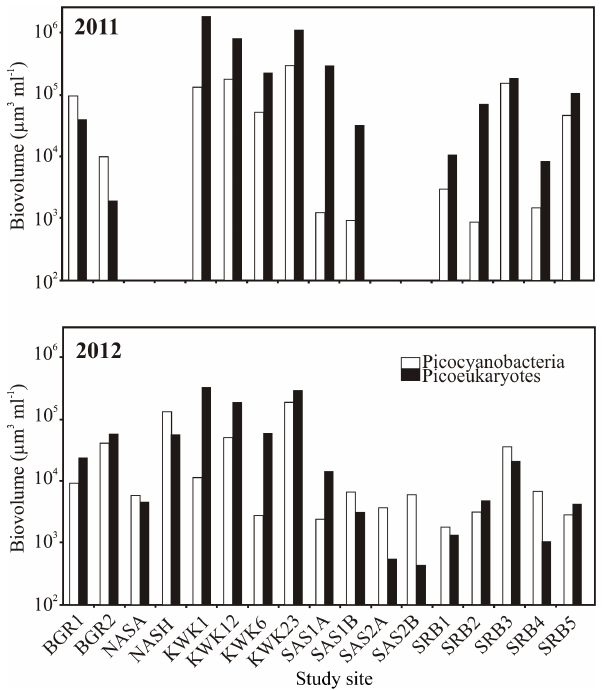
Figure 5. Picophytoplankton biovolume in the surface water of shallow rock-basin (SRB) and permafrost thaw lakes located on clays (KWK, BGR, NAS) and peatlands (SAS).